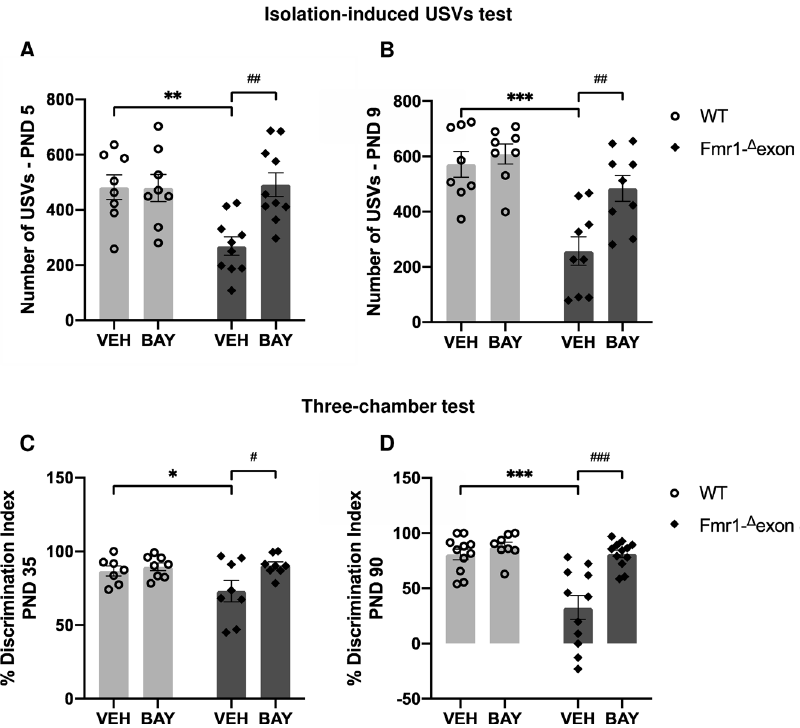
Fig. 2 Pharmacological inhibition of PDE2A normalizes the communicative and social de fi cits displayed by Fmr1- Δ exon 8 rats in the course of development. Fmr1- Δ exon 8 rats emit less USVs when removed from the nest at PNDs 5 ( A ) and 9 ( B ), and this communicative de fi cit is reversed upon BAY607550 injection (PND 5: WT-VEH, n = 8; WT-BAY, n = 8; KO-VEH, n = 10; KO-BAY, n = 10; PND 9: WT-VEH, n = 8; WT-BAY, n = 8; KO-VEH, n = 9; KO-BAY, n = 9). Fmr1- Δ exon 8 juvenile and adult rats display reduced sociability in the three-chamber test, as they show a lower discrimination index ( C , D ). At both ages, the altered phenotype displayed by Fmr1- Δ exon 8 rats is rescued by PDE2A inhibition (PND 35: WT-VEH, n = 7; WT-BAY, n = 8; KO-VEH, n = 8; KO-BAY, n = 8; PND 90: WT-VEH, n = 11; WT-BAY, n = 8; KO-VEH, n = 11; KO-BAY, n = 12). Data represent mean ± S.E.M. * p < 0.05, ** p < 0.01, *** p < 0.001 vs WT-VEH group, # p < 0.05, ## p < 0.01, ### p < 0.001 vs Fmr1- Δ exon 8 -VEH group (Student ’ s – Newman – Keuls post hoc